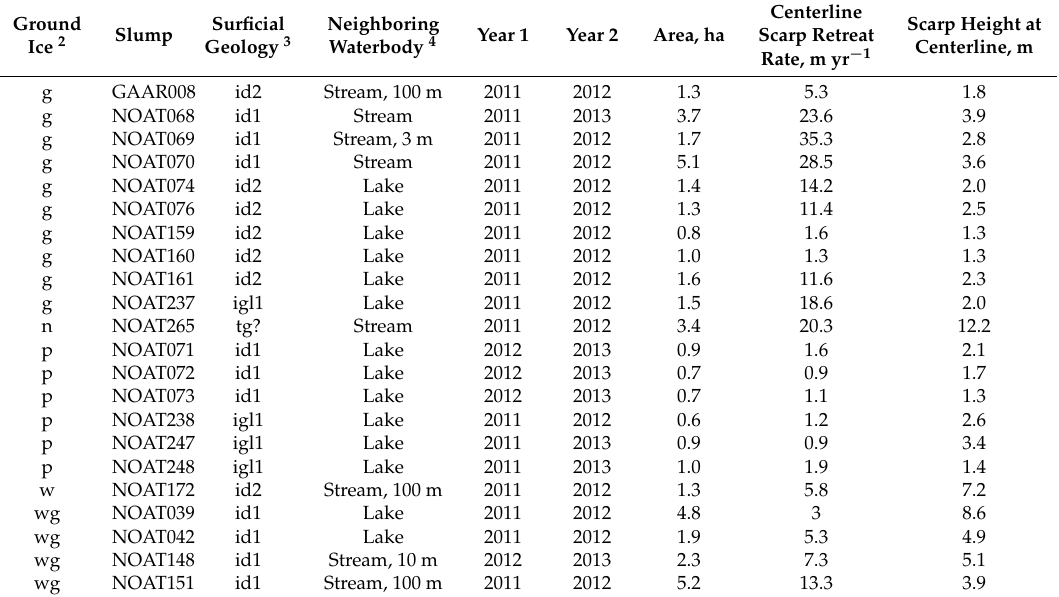
Table 2. Slump ground ice, geologic setting, and growth rate characteristics along the centerline for an example year. 1